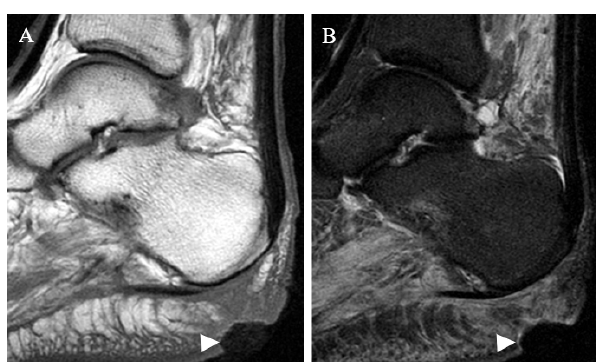
Figure 2. Sagittal T1 (a) and STIR (b) sequences in a 46-year- old female patient who underwent MRI for the evaluation of os- teomyelitis. There is a prominent cutaneous ulcer (arrowhead) with underlying soft tissue changes that extend to bone. The calcaneal bone marrow signal is normal. This patient improved with conser- vative measures. A follow-up MRI (not shown) demonstrated reso- lution of the ulcer with normal calcaneal bone